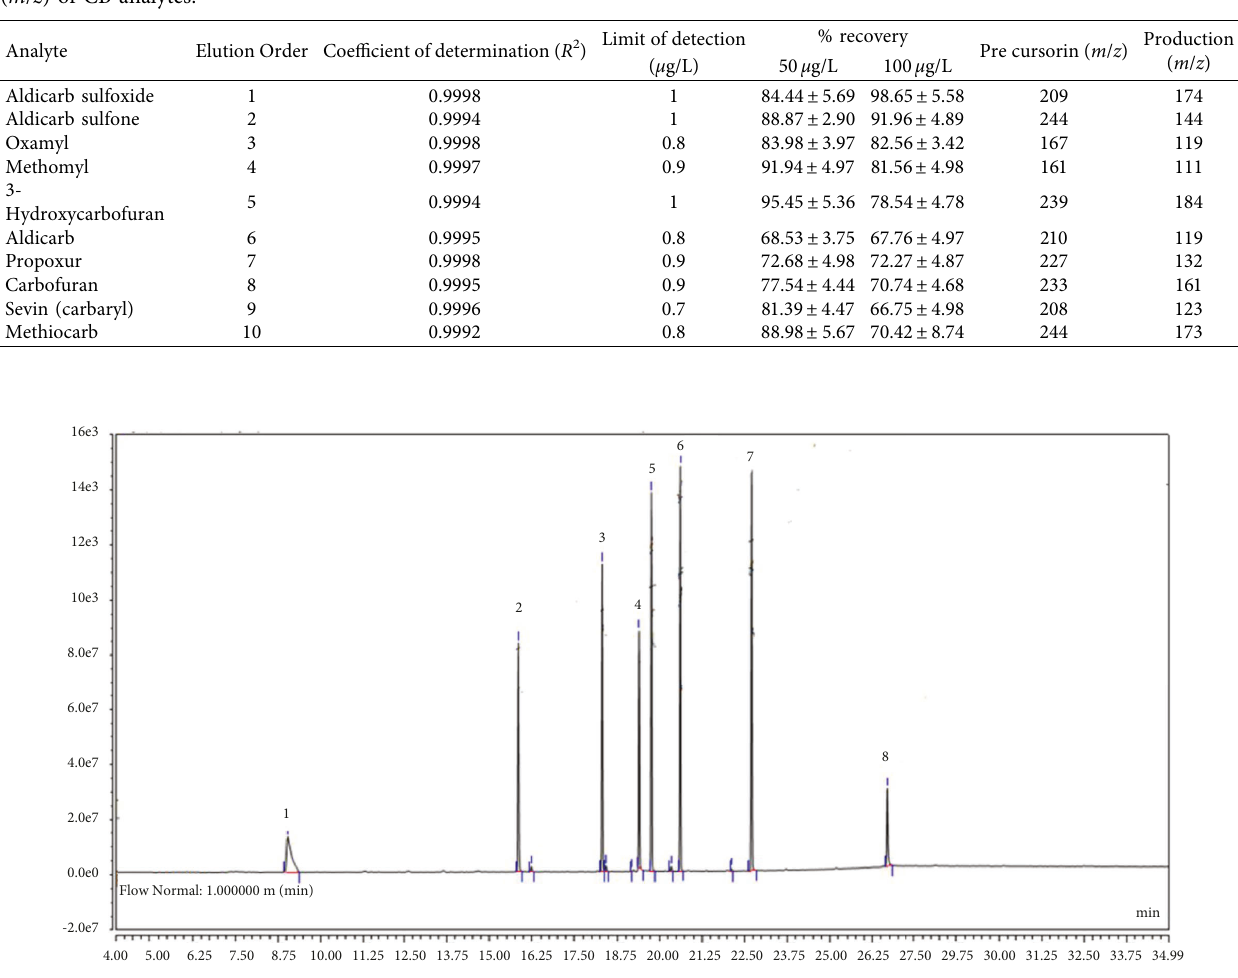
Figure 2: Chromatogram showing peaks of OP pesticide standards. The corresponding peaks of each residue are presented in the following order: 1: dichlorvos; 2: MOCAP (ethoprophos); 3: disulfoton; 4: methyl parathion; 5: ronnel; 6: dursban (chlorpyrifos); 7: tokuthion; 8: guthion (azinphos methyl).